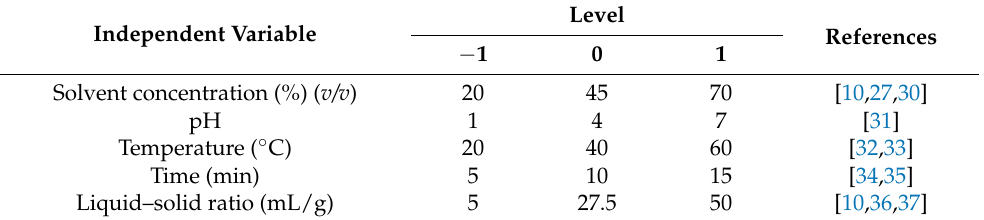
Level References − 1